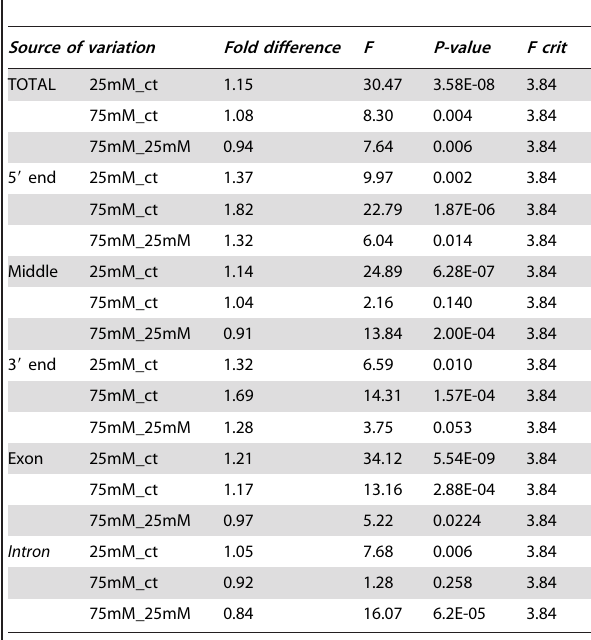
Table 5. Statistical analysis of differences in methylation levels in different parts of the gene